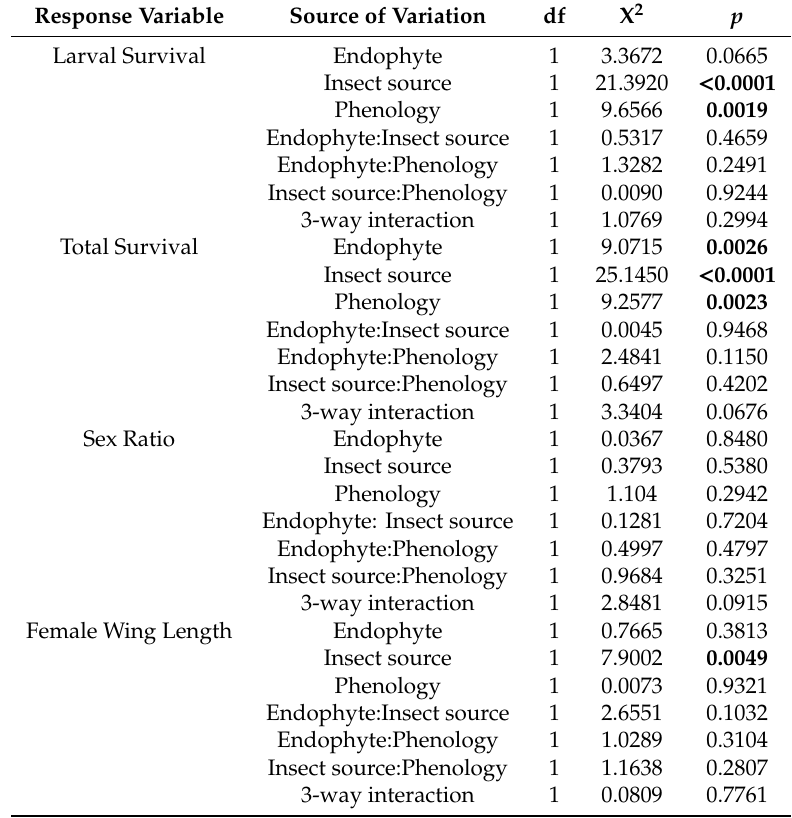
Table 1. Summary of generalized linear mixed models evaluating the influence of a native endophytic fungus, larval source, and phenology on larval (i.e., second instar to pupa) and total (i.e., second instar to adult emergence) survival, adult sex ratio and female wing lengths of eastern spruce budworm reared on 14 white spruce trees with and 14 trees without the endophyte in 2012. Second-instar larvae from a laboratory colony or field population (insect source) were placed in the mid-crown of study trees approximately one or two weeks before budburst (phenology). Tree was included as a random variable in the mixed e ff ects models (either GLMM with logit link or